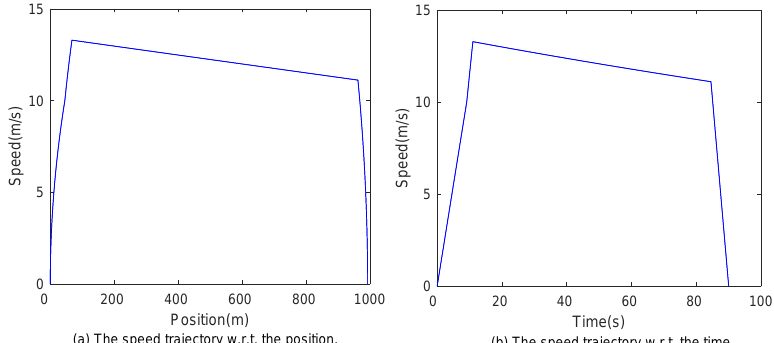
Figure 4. Optimal speed trajectory of Jiugong–Yizhuangqiao. ( a ) The speed trajectory w.r.t. the position; ( b ) The speed trajectory w.r.t. the time.